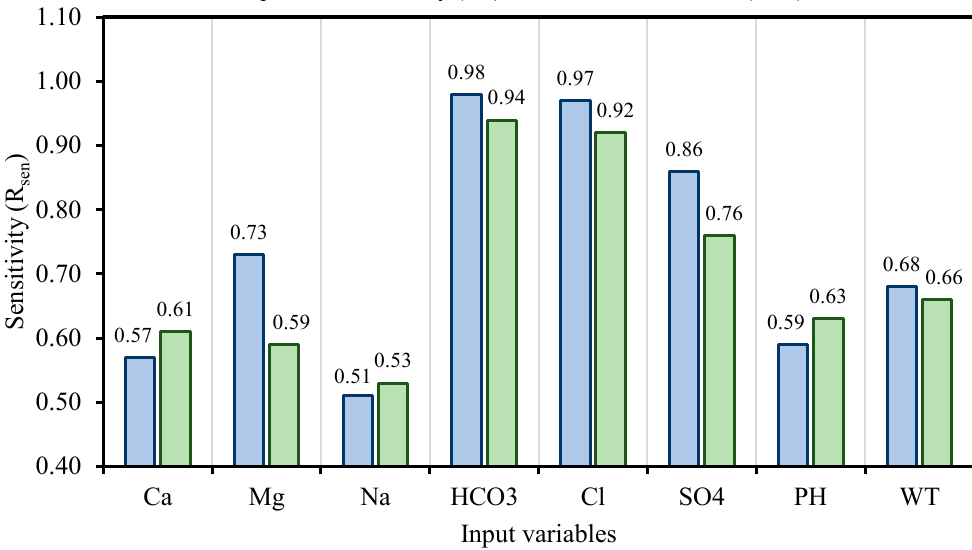
Figure 9. Contribution of input variables for the prediction of EC and TDS.